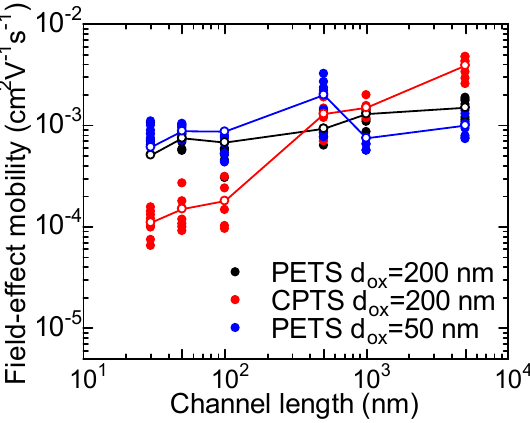
Figure 6. Channel length dependence of field-effect mobilities of F8T2 FETs on PETS- and CPTS-treated SiO 2 insulators with different SiO 2 thicknesses ( d ox ). The open circles indicate average field-effect mobilities for each channel length.